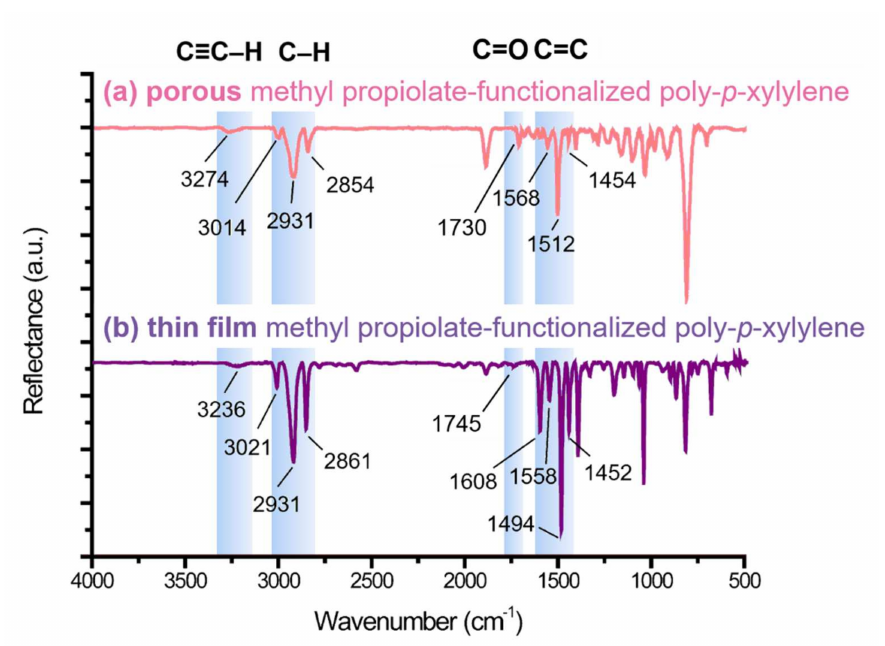
Figure 4. FT-IR spectra showing the comparison of ( a ) the porous methyl propiolate-functionalized poly- p -xylylene fabricated from an ice template and ( b ) the thin film methyl propiolate-functionalized poly- p -xylylene that was deposited on a conventional gold-coated silicon wafer solid surface. The characteristic bands were found to be consistent in both ( a , b ) to confirm the chemical